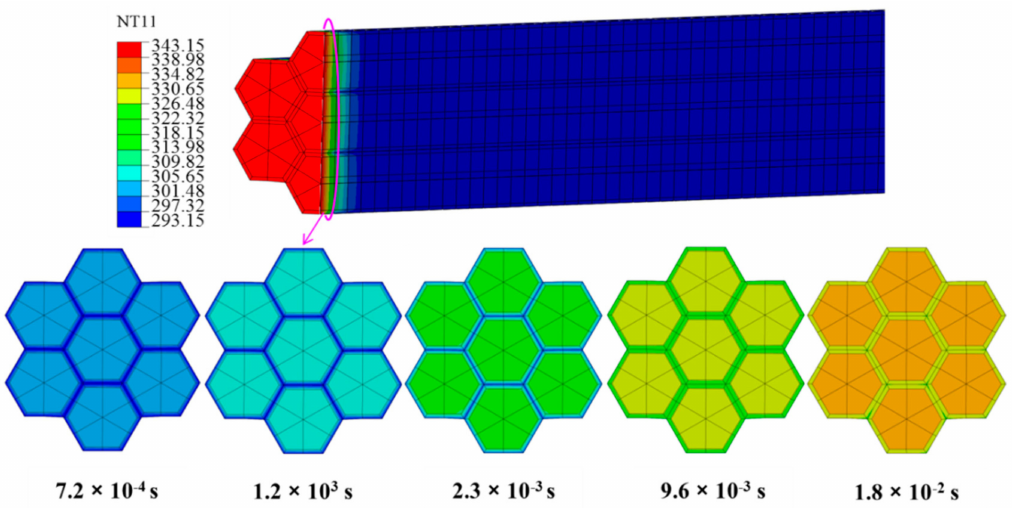
Figure 6. Temperature distributions at the beginning of heat transfer.